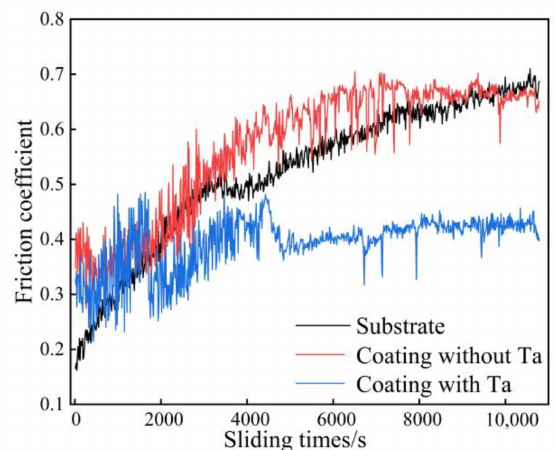
Figure 10. The relationship between friction coefficient and sliding time of the substrate and the coatings in alkaline